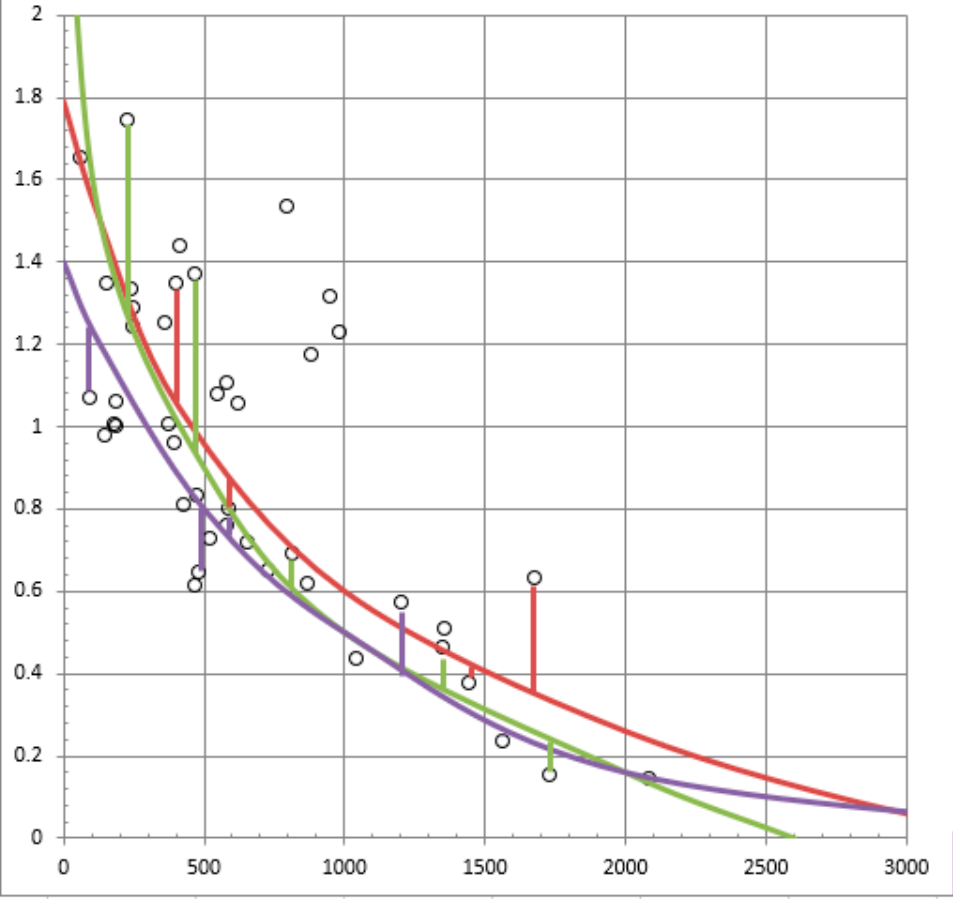
Figure 1. Different fitting functions with exemplary residuals obtained by the Gauss-Newton-Method.